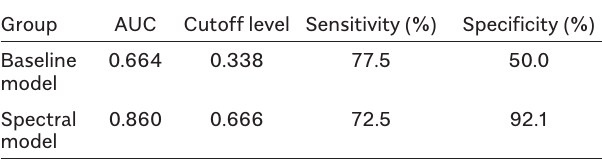
Table 6. ROC Curve Analysis of the 2 Logistic Regression Models Group AUC Cutoff level Sensitivity (%)